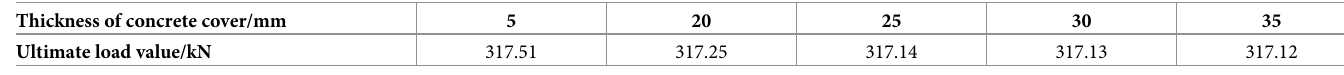
Table 16. Ultimate load value of reinforcement with different thickness of concrete